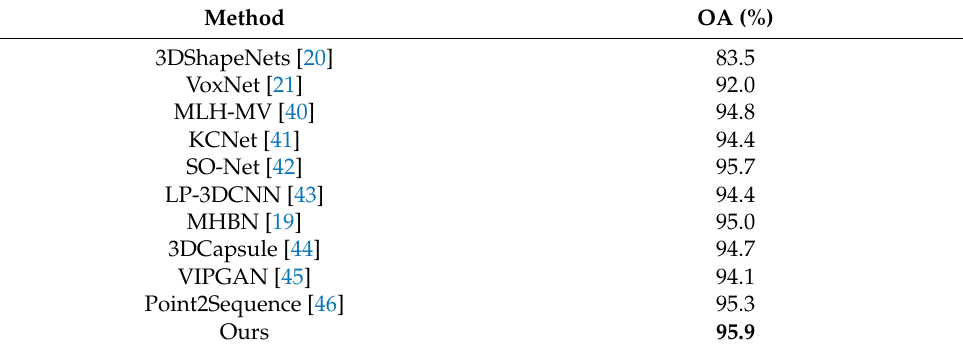
Table 3. Classification accuracy on